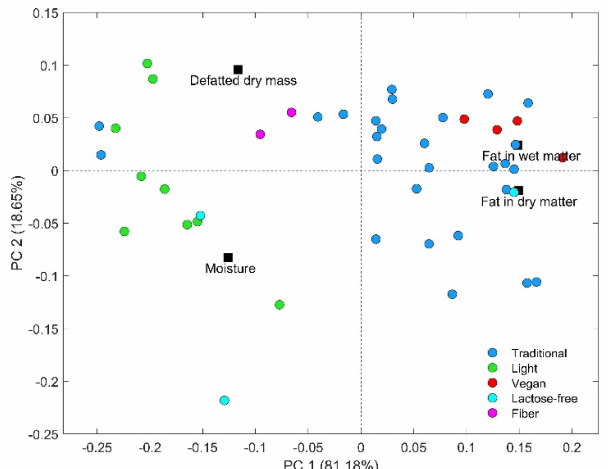
Figure 2. Scores (circles) and loadings (squares) biplot of the first two components of a PCA model of the RC